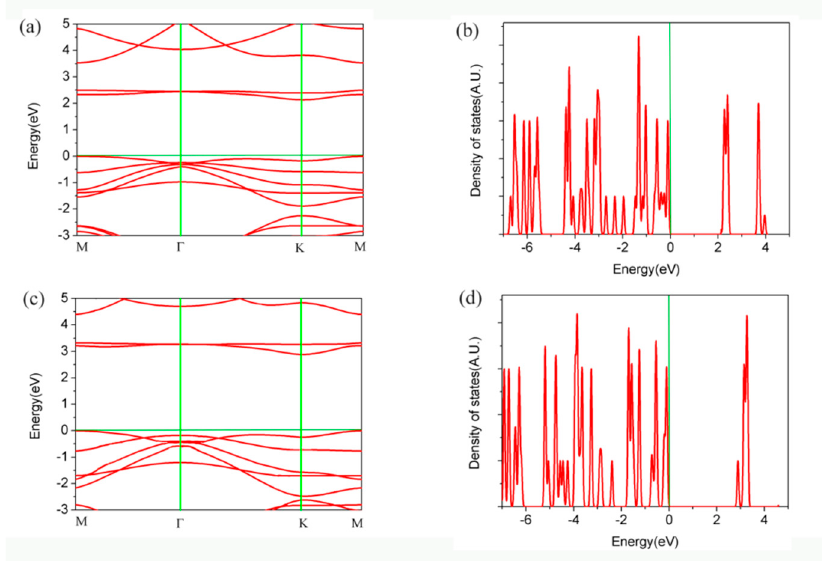
Figure 2. ( a ) Energy-band structure distributions and ( b ) electron density of states (DOS) of g–C 8 N 6 by PBE method; ( c ) energy-band structure distributions and ( d ) electron density of states (DOS) of g–C 8 N 6 by the HSE06 hybrid function method.